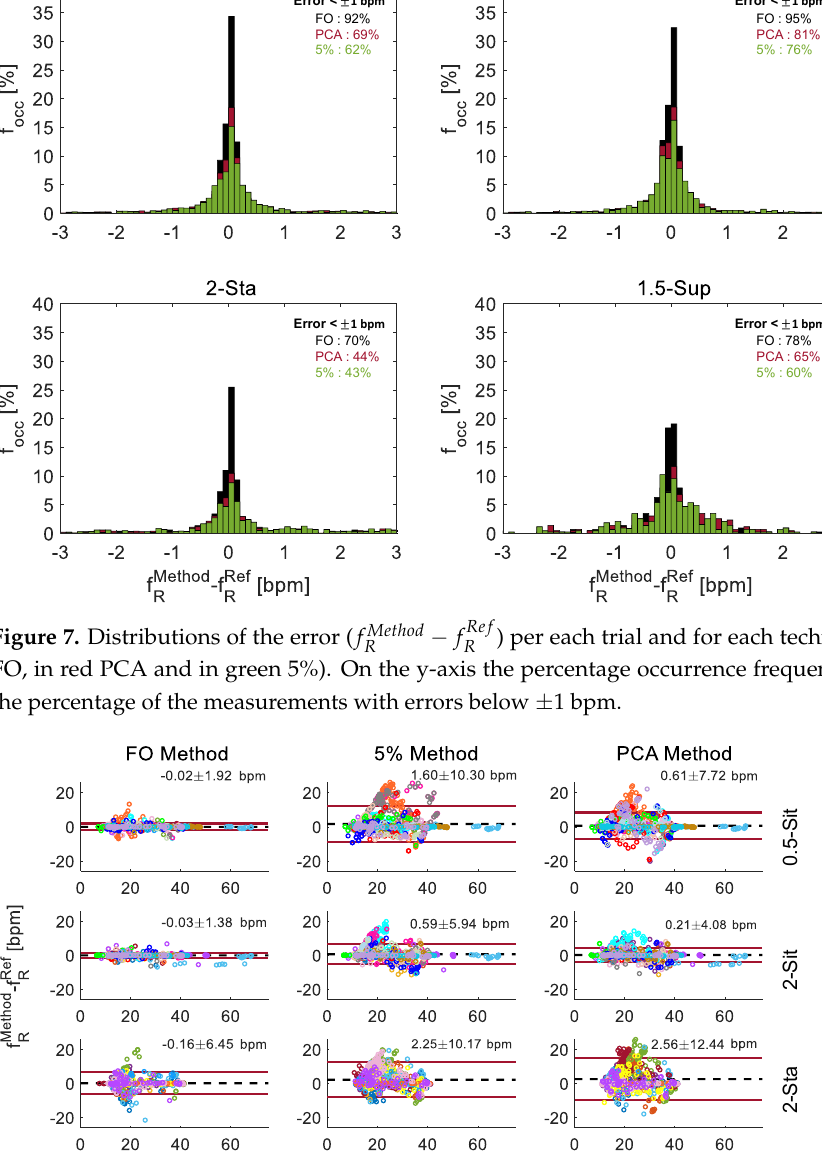
Figure 8. Bland–Altman analysis using the f R values obtained by the video signal collected for each subject (shown in different colours) posture and for each technique of extracting movement from images. The black dashed line represents the mean of difference (MOD); the two upper and lower lines represent the confidence interval given by the mean ± the 95% of the standard deviation of the points (LOAs). MOD can be interpreted as an indicator of the accuracy of the system and its value represents the systematic error of the proposed method to the reference. The smaller the variation of the mean within the confidence interval, the more likely it is that the two methods can be considered